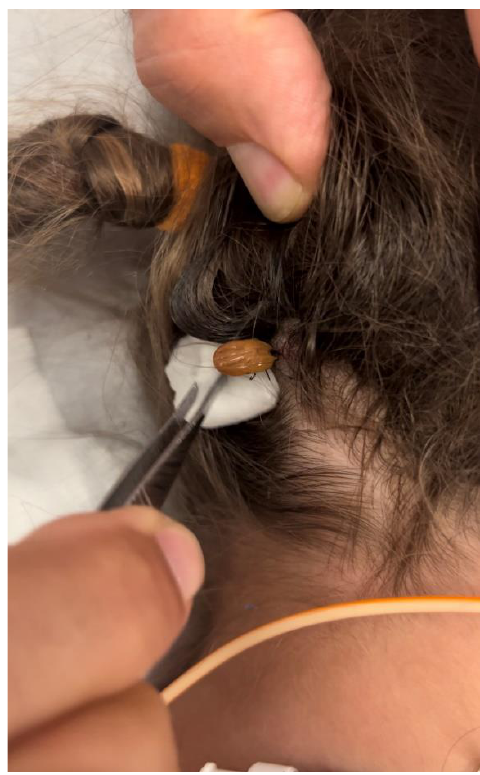
Figure 1. Engorged tick on the hairline. The tickborne illness PCR panels for Anaplasma, Babesia, Borrelia, Ehrlichia, and Lyme disease were negative. The tick was identified as the American dog tick ( Dermacentor variabilis ). Upon review of the patient’s head imaging, it was determined that the tick could be seen on the MRI (Figure 2) of the brain performed